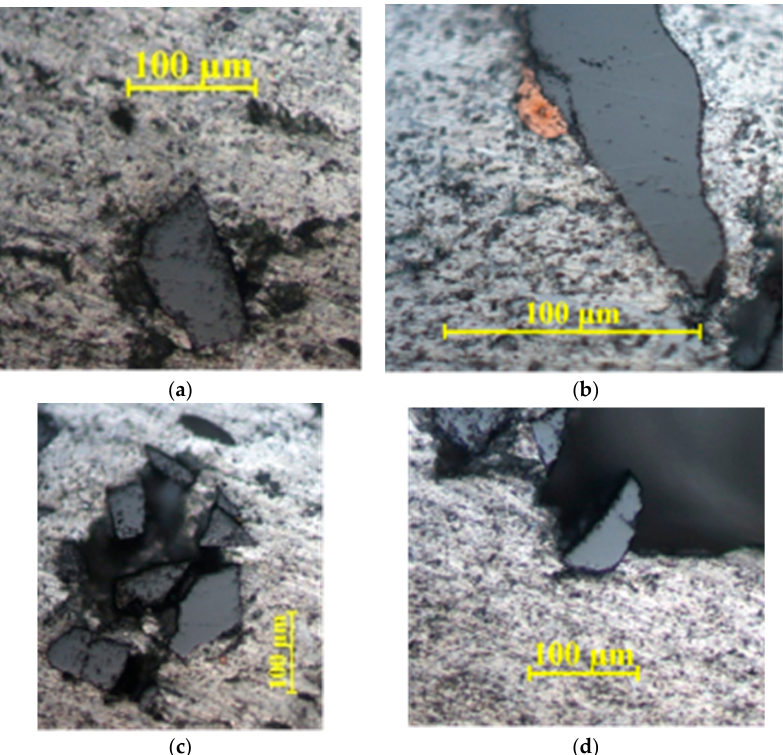
Figure 4. SiC particles distribution within the metallic base alloy — V 1 . ( a ) Central embedded SiC particle (×200), ( b ) Cu on a SiC particle (×500), ( c ) SiC particles agglomeration (×200), ( d ) SiC particles agglomeration (×200).